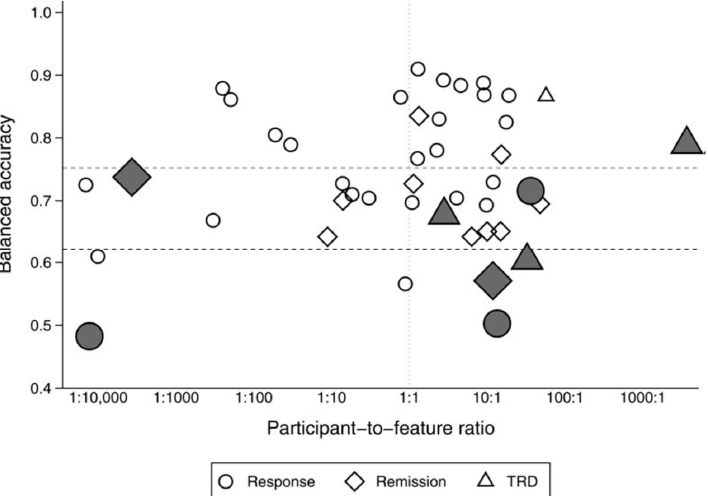
Figure 4. Balanced accuracy and participant-to-feature ratio in published machine learning studies of outcome prediction in the treatment of MDD. The x-axis plots the ratio of participants to predictive features. The y-axis plots the mean balanced accuracy within each study. Studies predicting response, remission, and TRD are plotted as circles, diamonds, and triangles, respectively. Adequate quality studies are highlighted with large, filled symbols. The dark gray horizontal dashed line shows the mean balanced accuracy of the eight adequate quality studies. The pale gray horizontal dashed line shows the average balanced accuracy of the other 45 studies (reproduced from [114]).